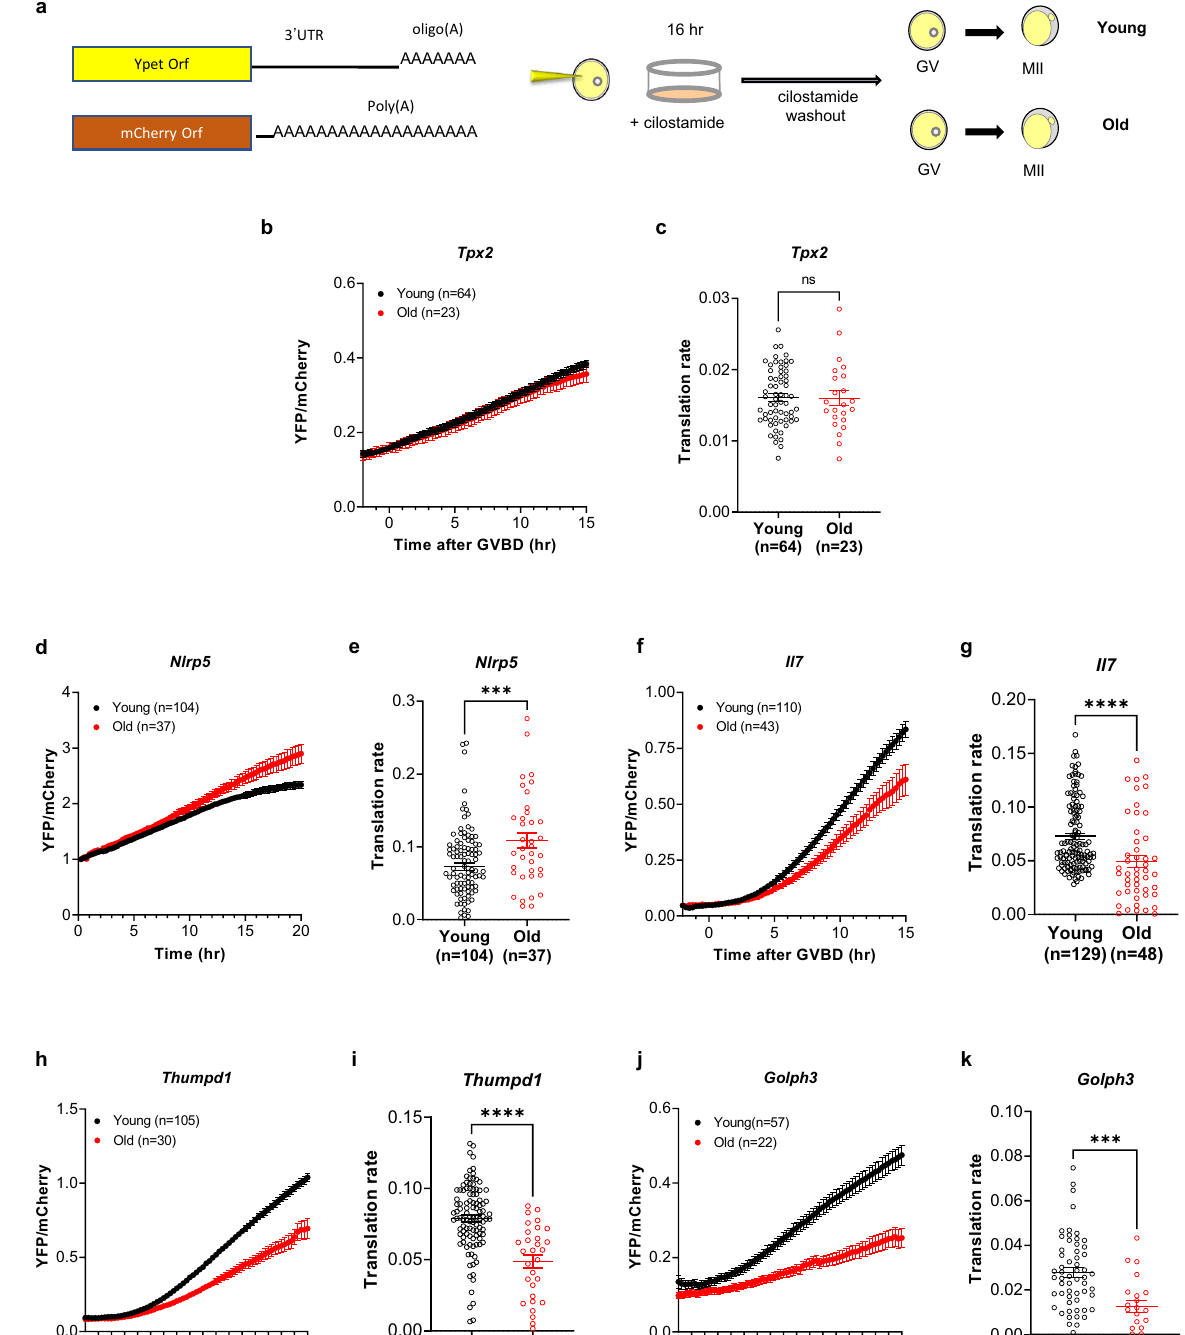
( b , f , h , j ). c , e , g , i , k Translation rates were calculated for each oocyte by linear regression of the reporter data between 5 and 10h ( b , j ), between 7 and 12h after GVBD ( f , h ), or between 15 and 20h after incubation time ( d ). Experiments were repeated three times with different batches of oocytes from different cohorts of aging mice and the data are shown as the mean ± SEM. Two-tailed unpaired Stu- dent ’ s t tests were used to evaluate statistical signi fi cance, ns not signi fi cant, e *** P =0.0008, g **** P <0.0001, h **** P <0.0001, k *** P =0.0002. Source data are provided as a Source Data fi